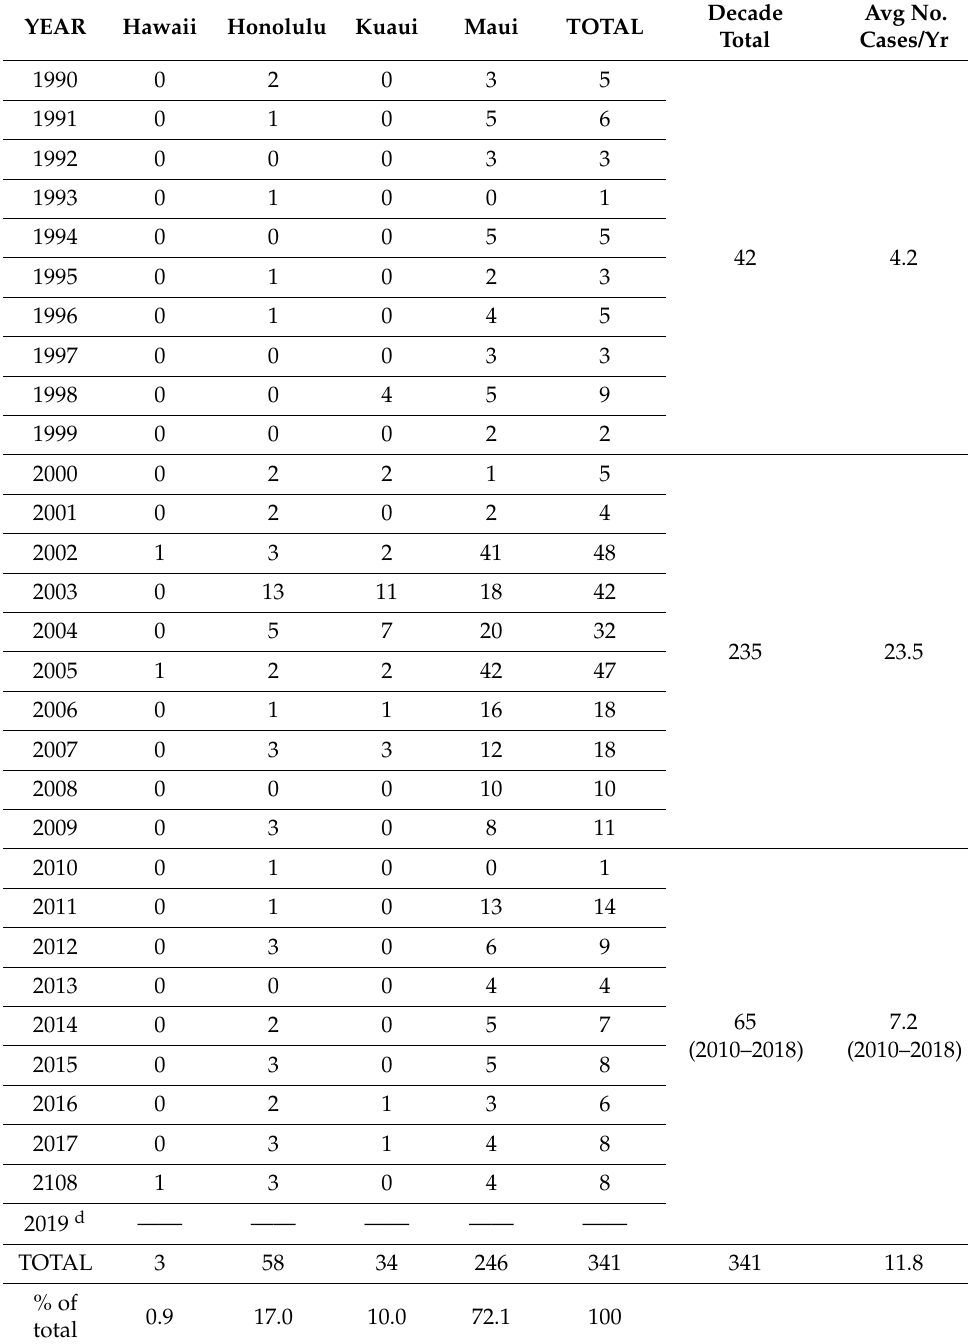
Table 4. Cases of Flea-borne Typhus by County in the State of Hawaii, 1990–2018. a,b,c